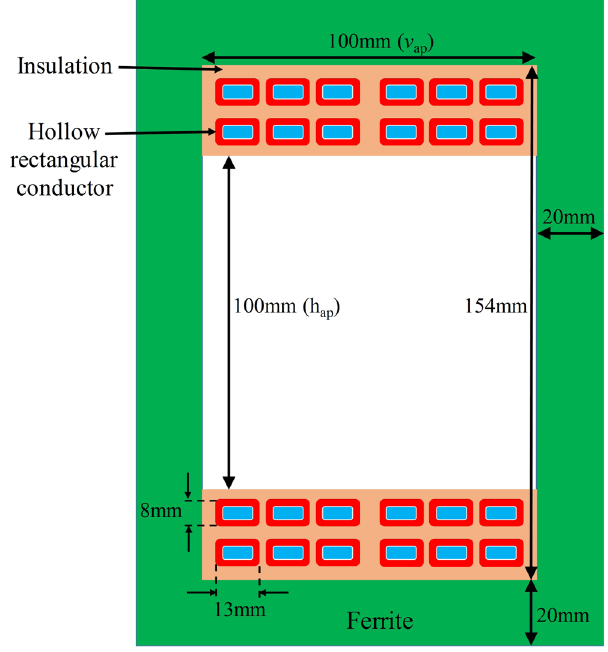
FIG. 6. Cross section of aperture of kicker magnet: rectangular coil conductors with 2 mm wall (red), insulation (brown), ferrite (green), and 100 mm × 100 mm aperture (white).